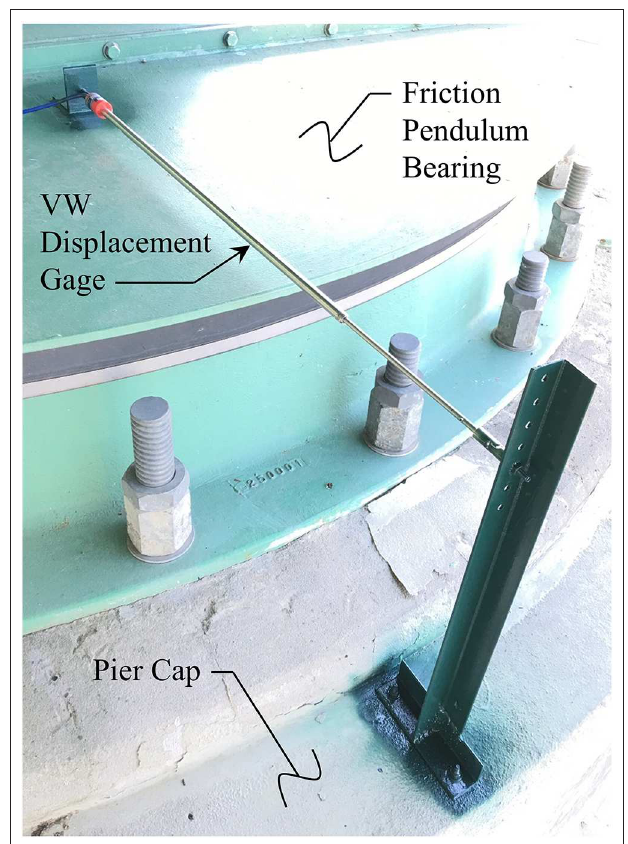
FIGURE 7 | Longitudinal displacement measurement setup.